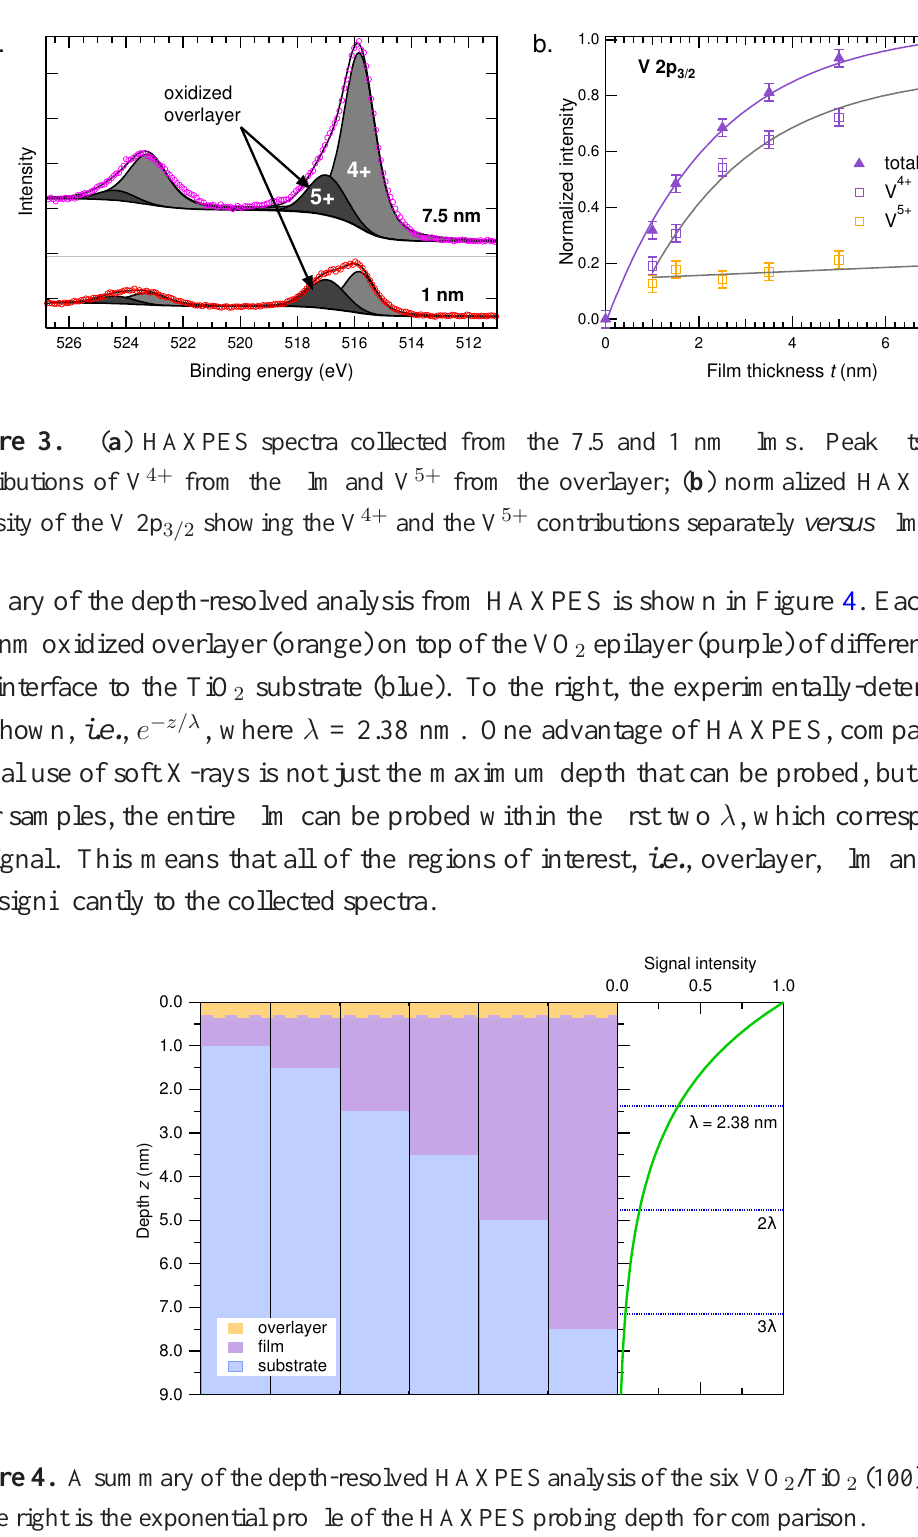
/TiO (100) thin films. 2 2